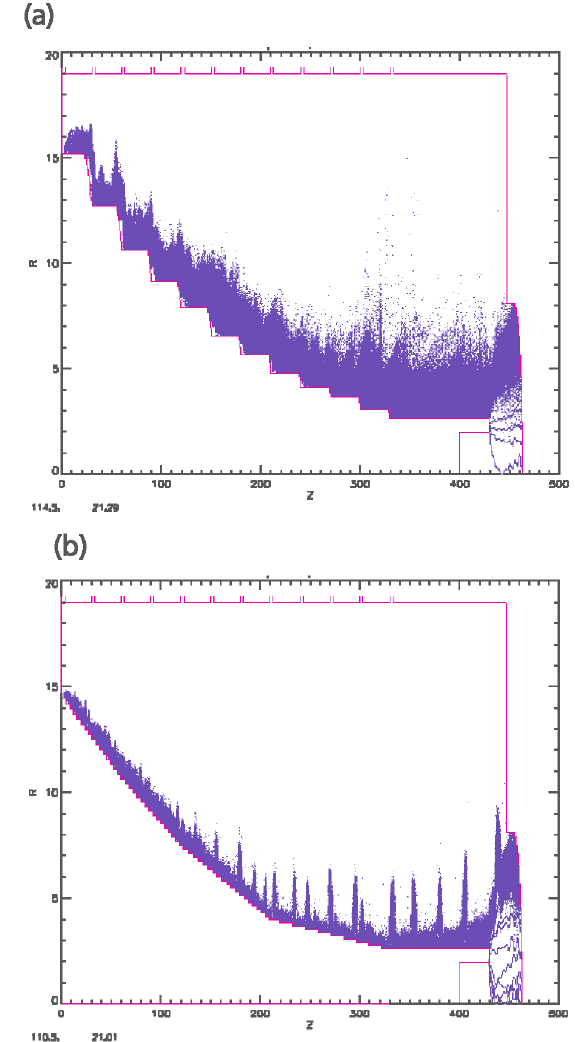
FIG. 16. (Color) LSP simulations of (a) stepped RITS stalk and (b) tapered RITS